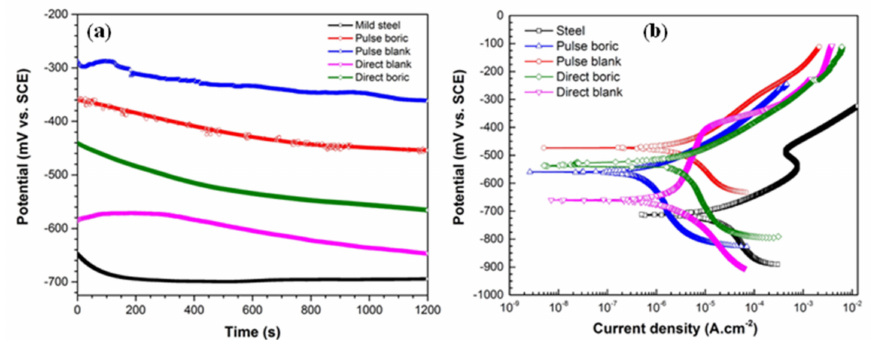
Figure 8. ( a ) Open circuit potential and ( b ) Potentiodynamic polarization curves of electrodeposited coatings immersed in 3.5 wt % NaCl with different conditions of